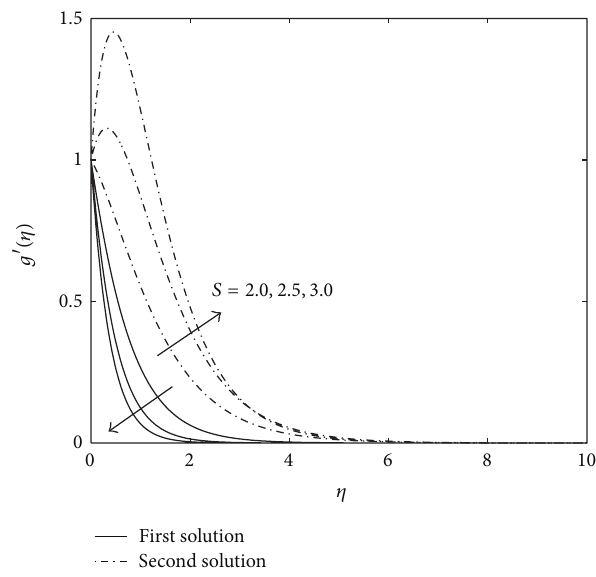
Figure 6: Velocity profiles in 𝑦 -direction for different values of 𝑆 when 𝜆 1 = −1.7 and 𝜆 2 = 1 .